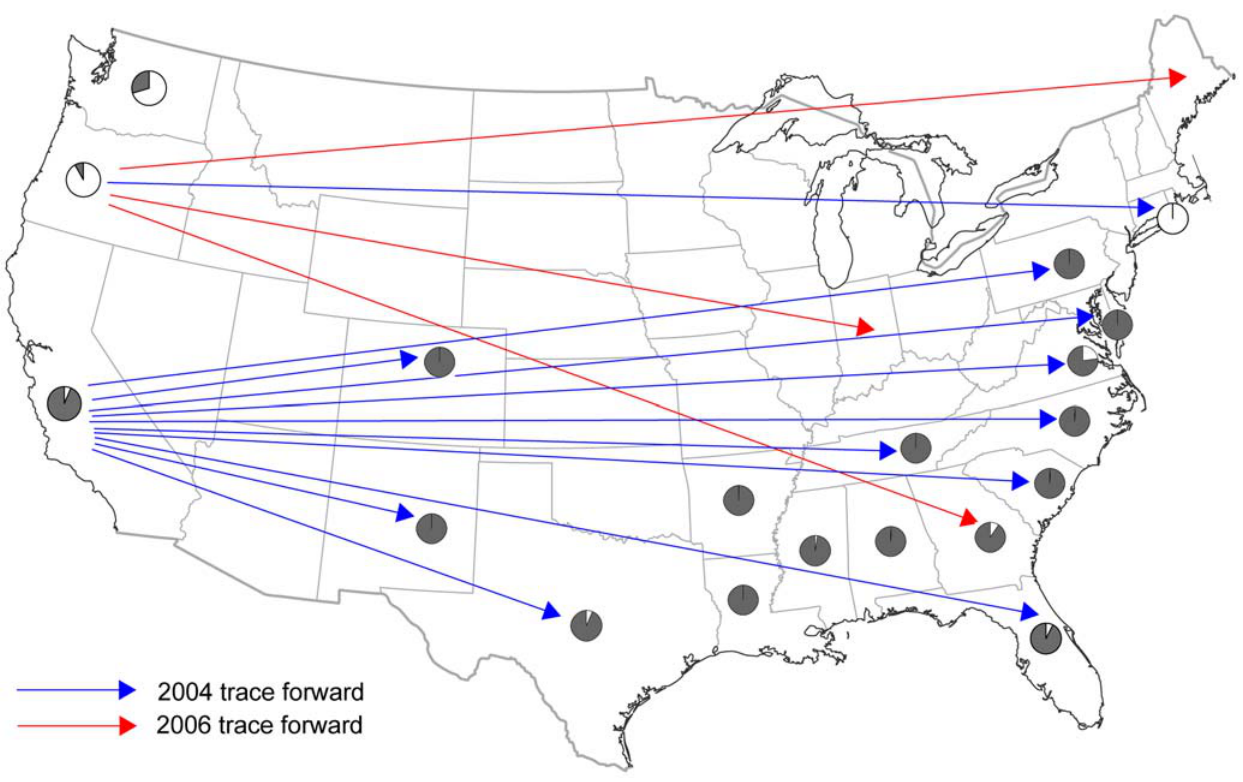
Figure 6. NA1 migration pathways. Pie charts show the distribution of the two groups of NA1 isolates, as identified by Structure, among sampled states. Arrows indicate confirmed P. ramorum -positive nursery trace forwards. Blue arrows are 2004 trace forwards and red arrows are 2006 trace forwards. There were no confirmed trace forwards in 2005 or 2007.